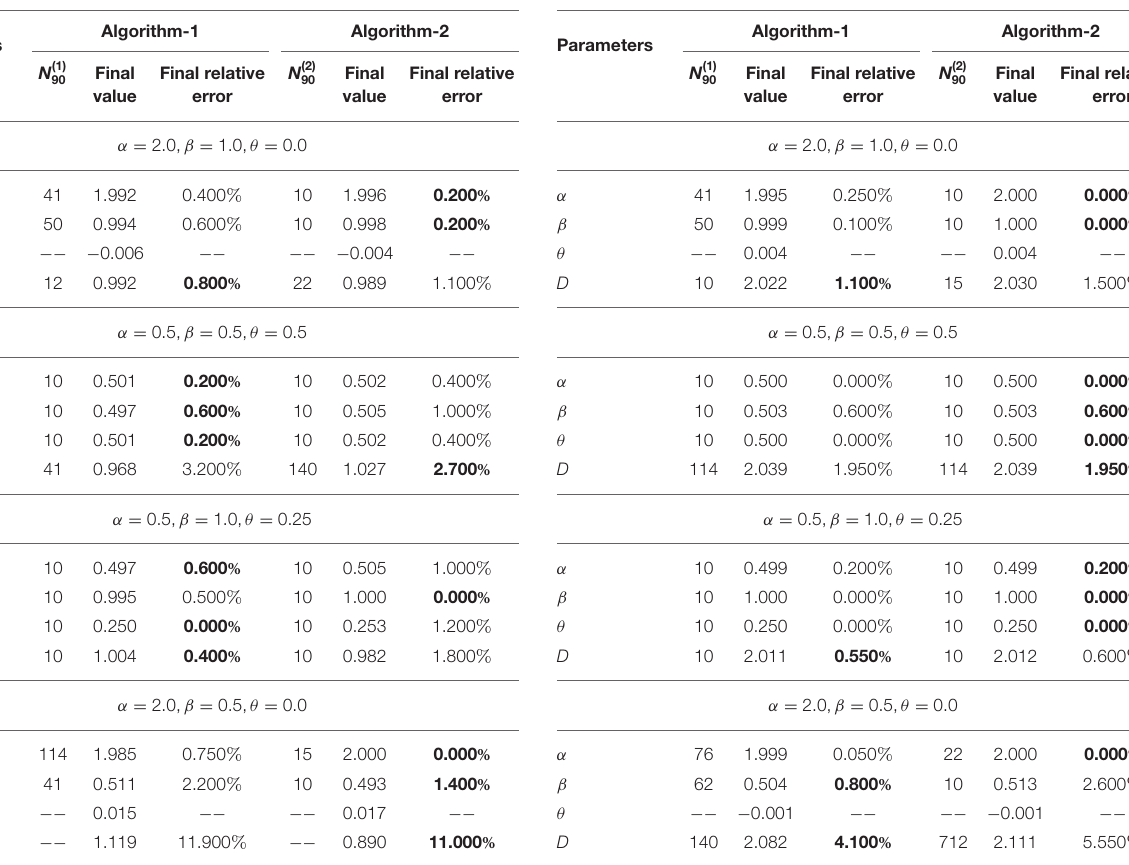
TABLE 2 | Numerical results for fractional diffusion parameter estimation with D =